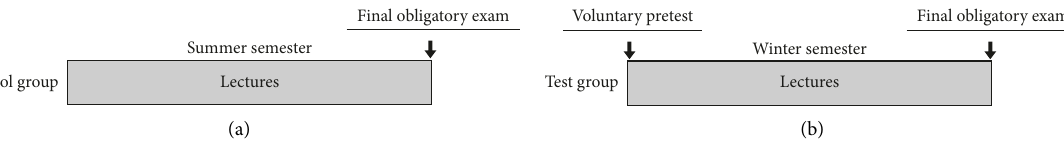
Figure 1: The initial voluntary test (pretest) contained 30 multiple-choice questions (single best choice, MC) with a passing grade of 60%. Students were motivated to take the initial test by the promise to get merit-based supplementary bonus points in the final examination. The final, obligatory test at the end of the course lectures contained the very same set of multiples choice questions. Students of a different semester which obtained the very same obligatory test after a course of pharmacology but without pretest served as control group. Total number of participating students: control group, n � 219; voluntary pretest, n � 147; obligatory test, n � 179; obligatory test without pretest, n � 37 (five students participated in the pretest but not in the obligatory test).